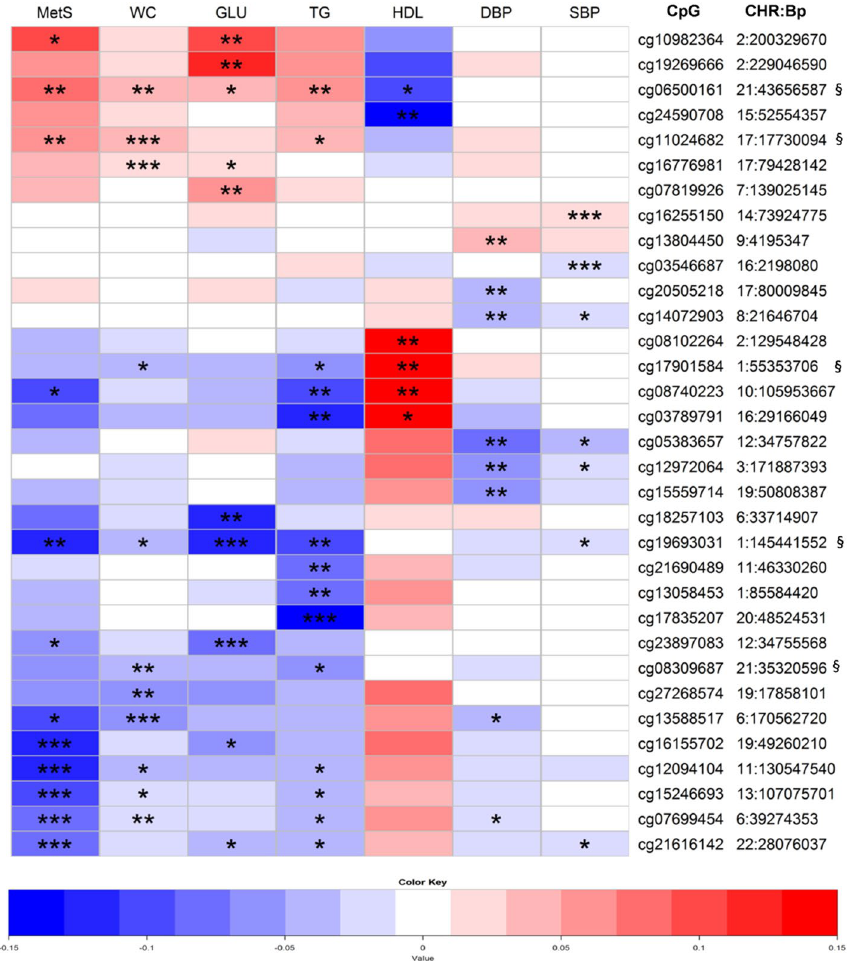
Figure 1. Association of CpG methylation sites across metabolic syndrome (MetS) and related phenotypes in the DILGOM cohort. The heat map includes the 33 most significant probes from the discovery epigenome-wide association studies (EWAS). Colours in the map refer to the effect size (beta) values for the probe in question. Beta values exceeding 0.15 are recoded as 0.15 and values below –0.15 are recoded as –0.15 in the figure. Stars indicate the P values from individual tests as follows: * P < 0.01, ** P < 0.0001, *** P < 1 × 10–6. Beta values from the waist circumference, diastolic blood pressure, and systolic blood pressure analyses are multiplied by 10 in order to provide more comparable and clinically relevant values for beta in the heat map. The detailed numeric data for the heat map is presented in the Supplementary Table 1. § indicates the successful replication of